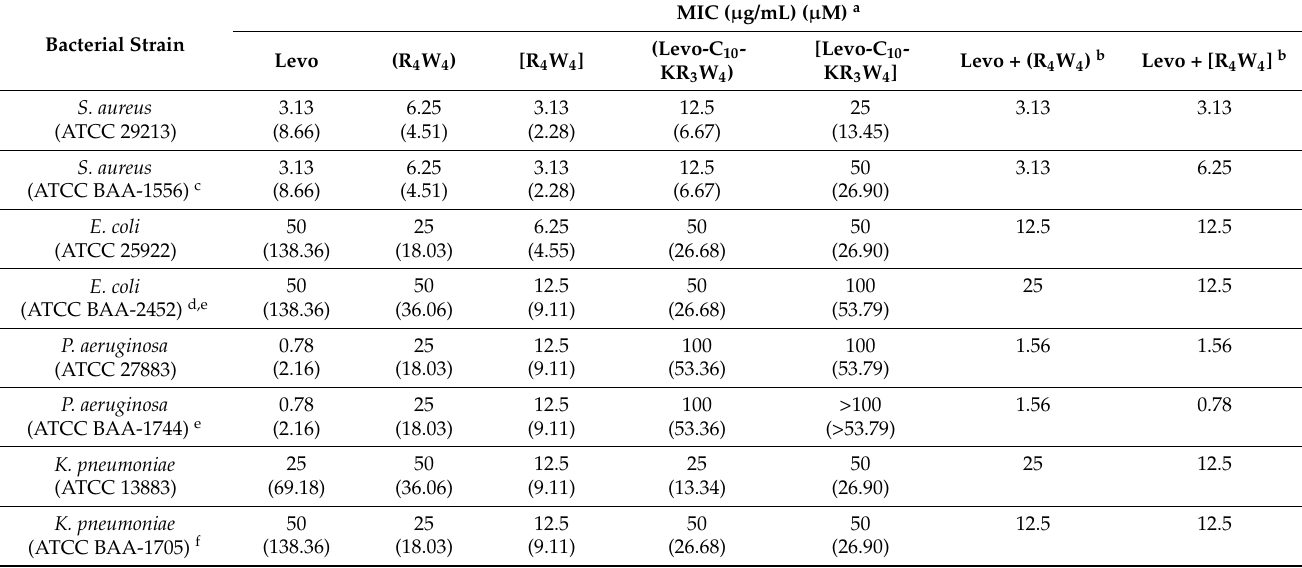
Table 1. Antibacterial activity of synthesized compounds.